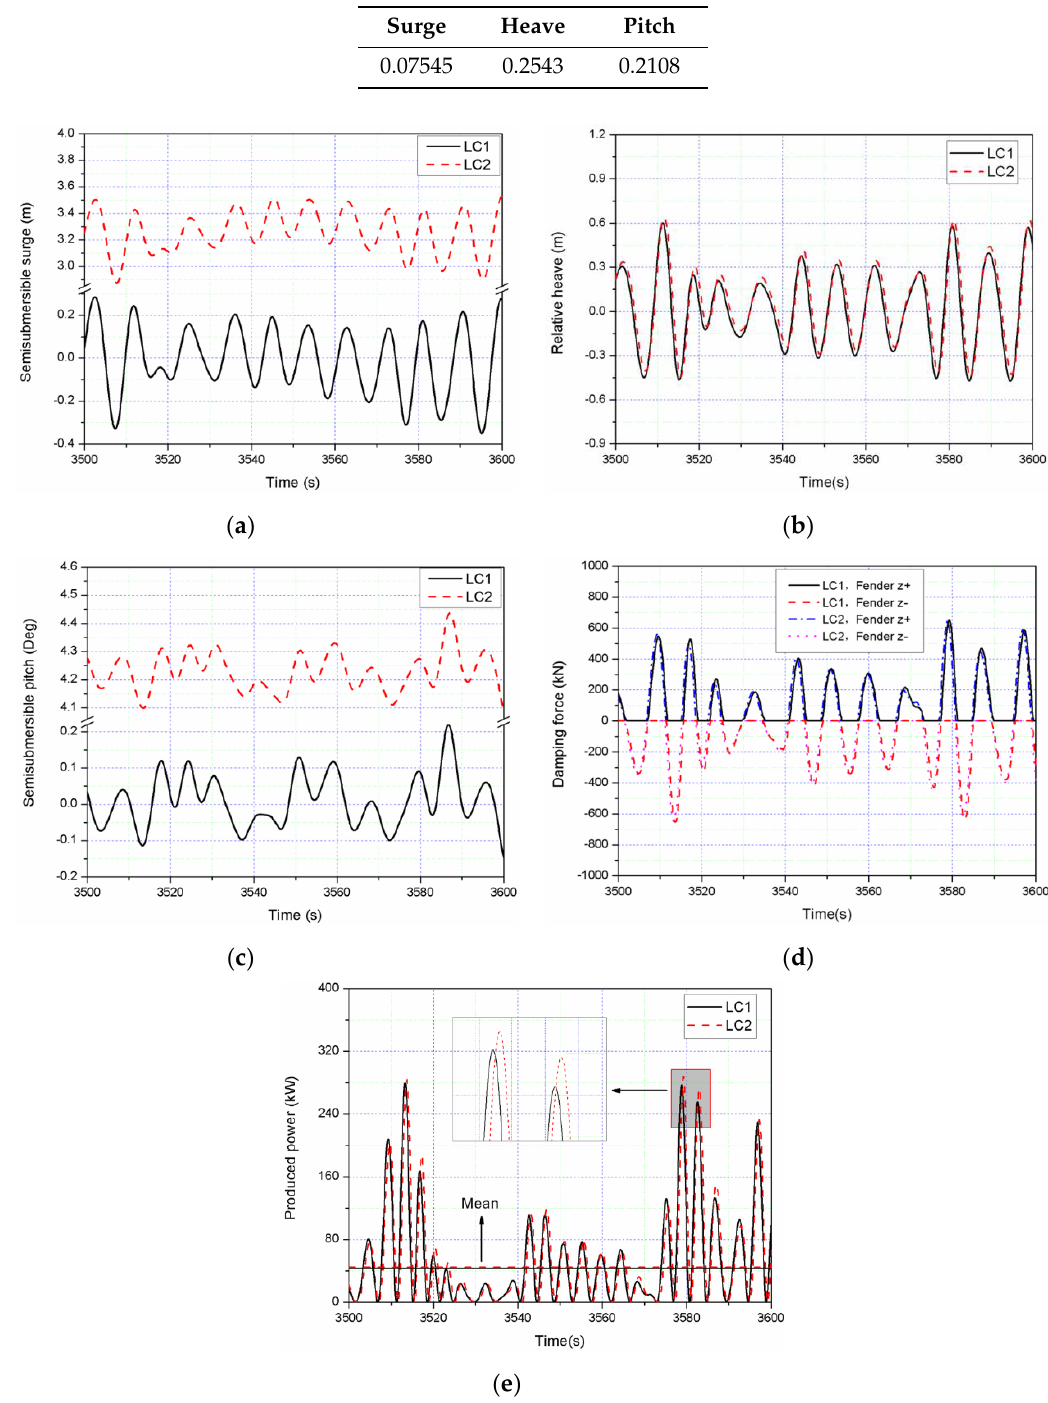
Figure 15. Comparisons of the time series of the responses for LC1 and LC2 of: ( a ) semisubmersible surge; ( b ) relative heave; ( c ) semisubmersible pitch; ( d ) damping force; ( e ) produced power.